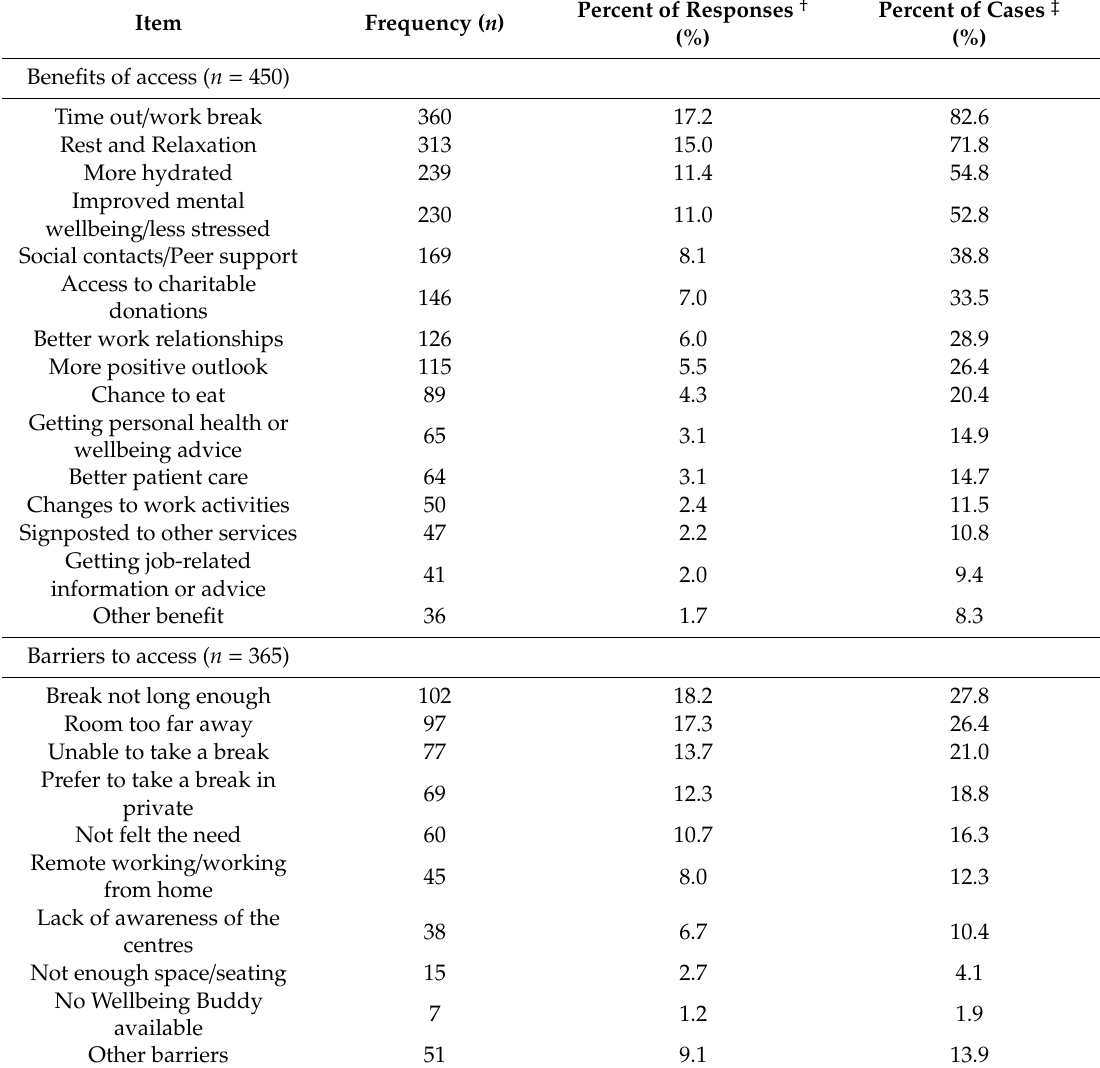
Table 4. Perceived benefits of wellbeing centres and barriers to